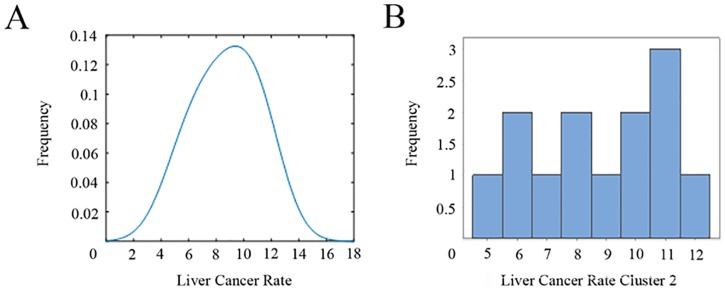
(A) Kernel estimator and (B) histogram for liver cancer rate in cluster 2.